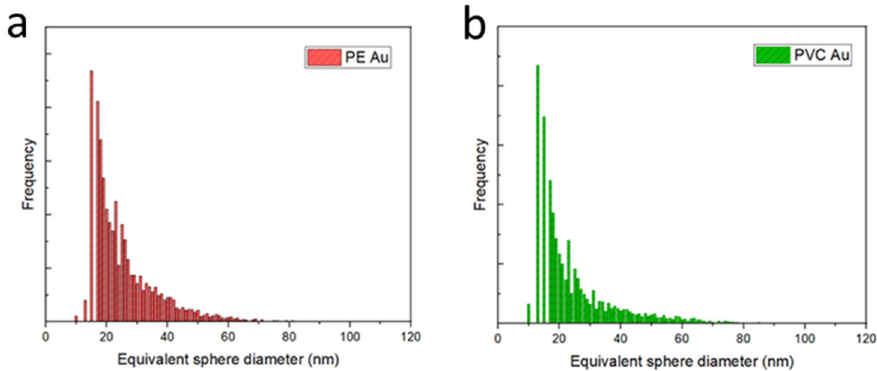
Figure 2. ( a ) Equivalent sphere diameter histogram distributions of gold-doped polyethylene (PE Au) and ( b ) polyvinyl chloride (PVC Au) nanoplastics, acquired in the single-cell mode of the ICP-MS.